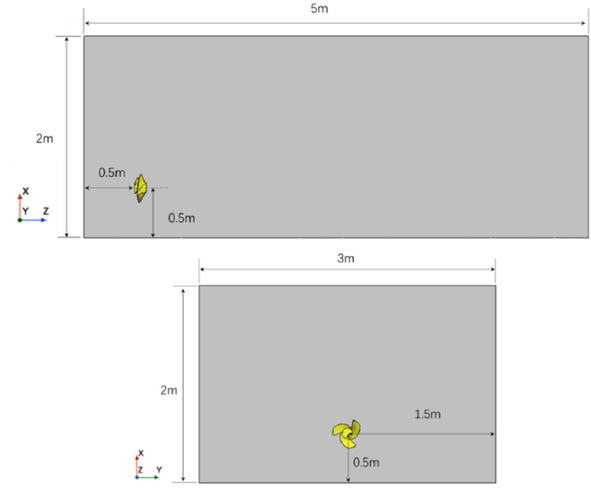
Figure 1. Arrangement of submersible mixer.